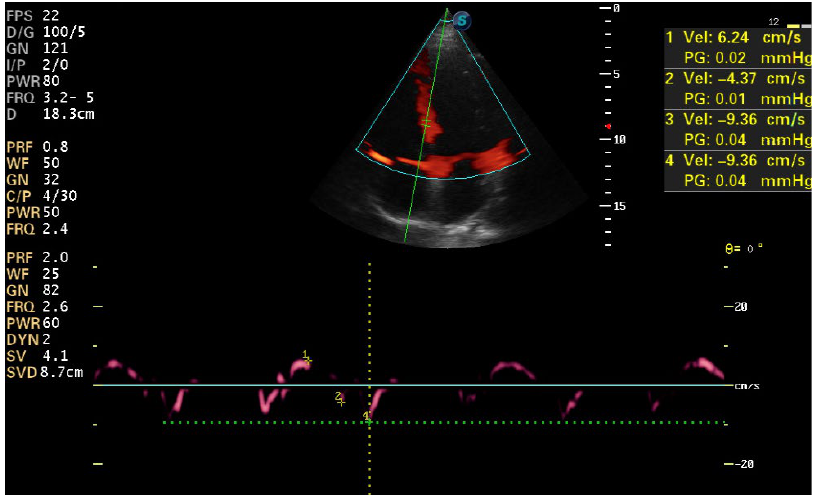
Figure 3. Case 1—Tissue Doppler Imaging septum evaluation (1-S wave, 2-e’ wave, 3,4-a’ wave).